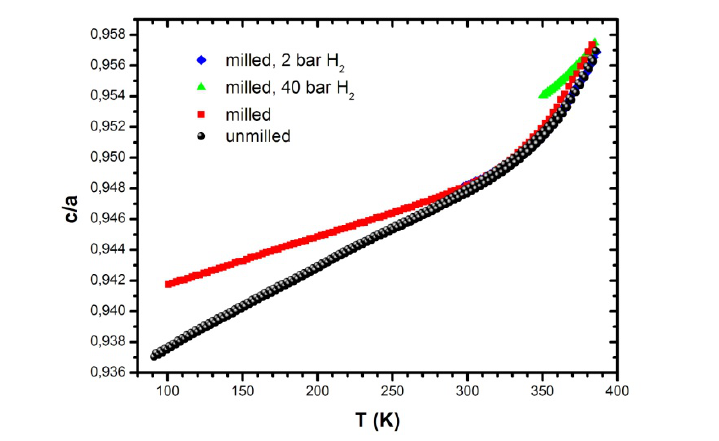
Figure 11. Axial ratios of the orthorhombic LiBH measured under argon in its milled (red 4 squares, 100–383 K) and unmilled (black circles, 91–385 K [14]) states compared with measured under 2 (blue lozenges, 297–386 K) and 40 (green those for milled LiBH 4 triangles, 350–385 K) bar of